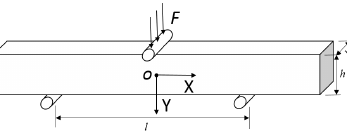
Figure 2. Scheme of three-point bending test.